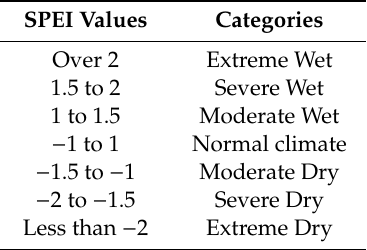
Table 3. Categorization according to the Standardized Precipitation-Evapotranspiration Index (SPEI)